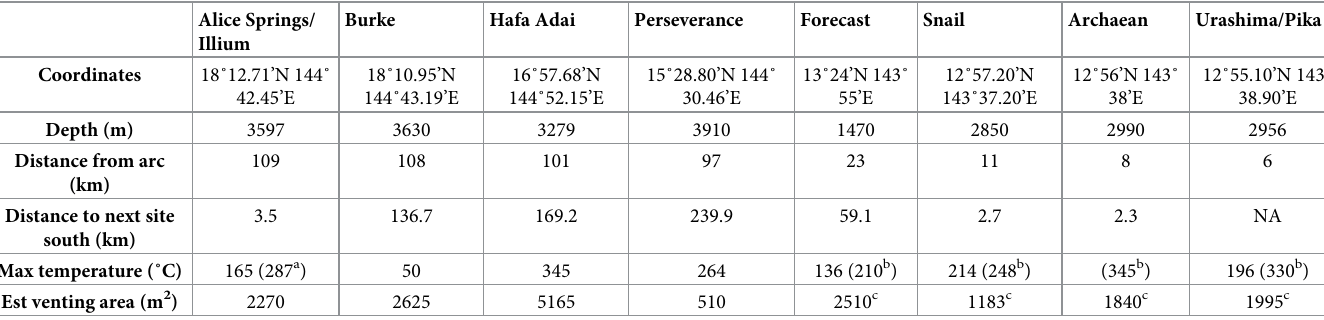
Table 1. Environmental variables for the Mariana back-arc vent